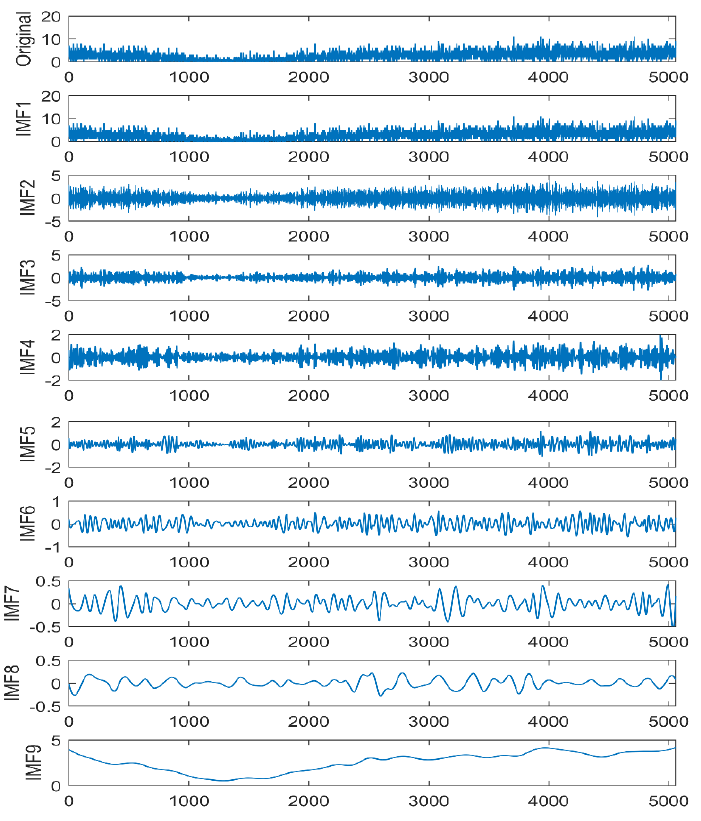
Figure 7. Decomposition effect of the EEMD method.